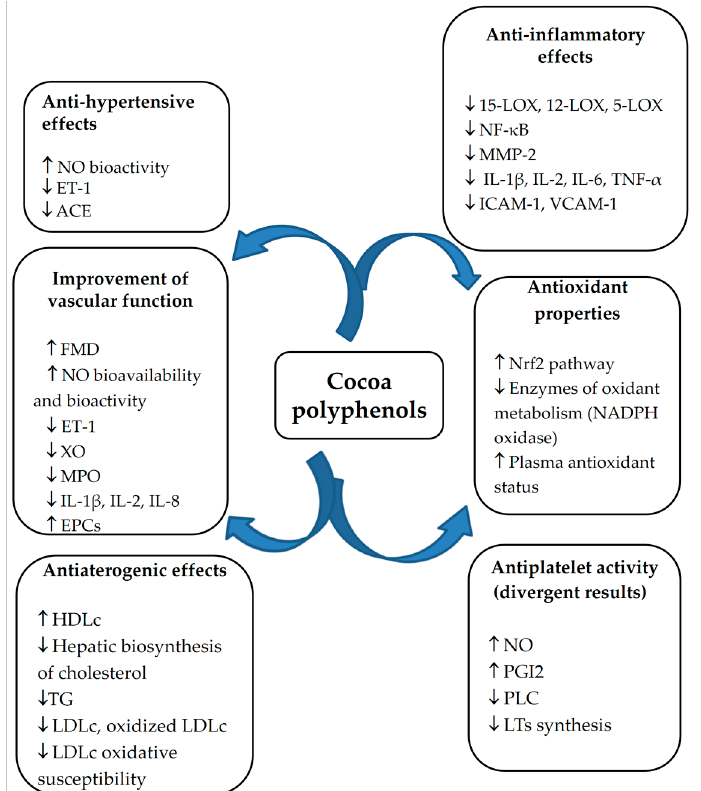
Figure 5. Main cardioprotective properties of cocoa polyphenols. Abbreviations: ACE, angiotensin-converting enzyme; EPCs, endothelial progenitor cells; ET-1, endothelin 1; FMD, flow-mediated dilation; HDLc, high-density lipoprotein-cholesterol; ICAM, intercellular adhesion molecule; IL, interleukin; LDLc, low-density lipoprotein-cholesterol; LOX, lipooxygenase; LTs, leukotrienes; MMP-2, matrix metalloproteinase 2; MPO, myeloperoxidase; NADPH, reduced nicotinamide adenine dinucleotide phosphate; NF- κ B, nuclear factor kappa-light-chain-enhancer of activated B cells; NO, nitric oxide; Nrf2, nuclear factor erythroid-related factor 2; PGI2, prostaglandin I2; PLC, phospholipase C; TG, triglycerides; TNF, tumor necrosis factor; VCAM, vascular cell adhesion molecule; XO, xanthine oxidase.